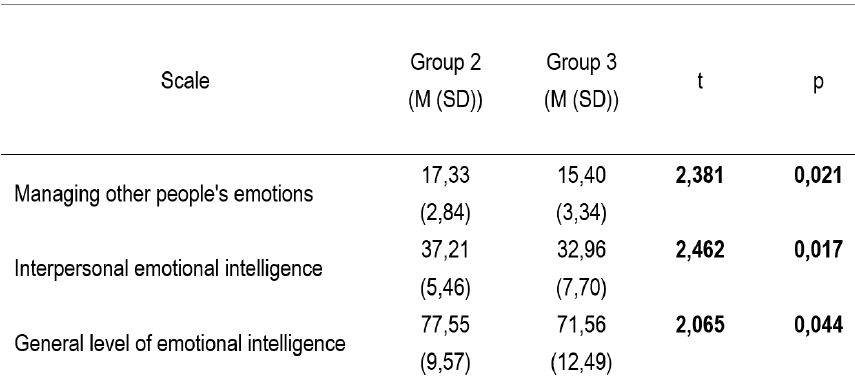
Indicators of emotional intelligence of mentors with average and low levels of success